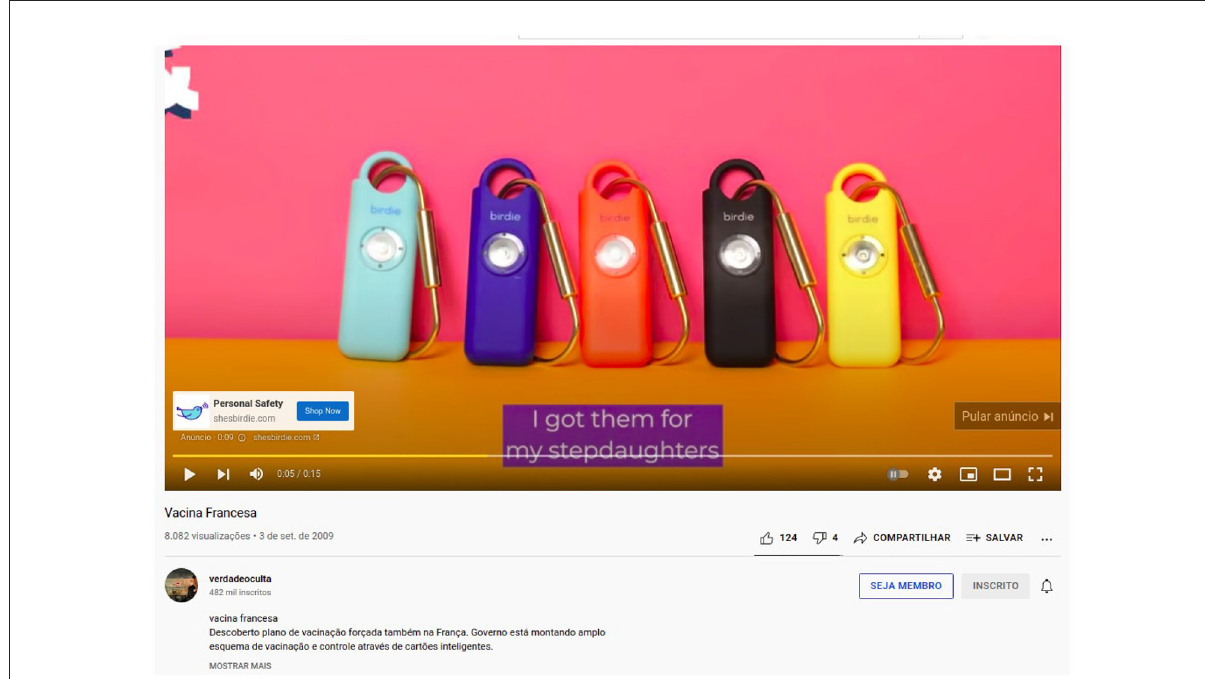
FIGURE2 Screenshot of one of the first videos from the channel Verdade Oculta published in 2009 and still monetized by YouTube. The video says that the 2009 H1N1 pandemic was a conspiracy to set a vaccine mandate and establish domination.